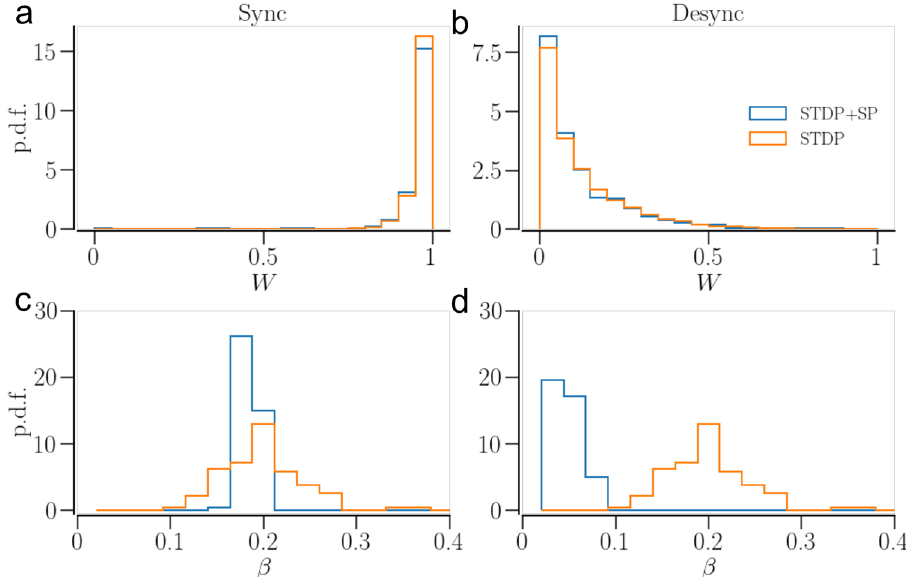
Figure 8. Statistics of synaptic weights and In-NDD for a network of identical oscillators in the asymptotic states belonging to the two plasticity schemes, STDP and STDP + SP. ( a ) and ( b ) show the synaptic weight distributions in a synchronized and a desynchronized state, respectively. ( c ) and ( d ) show the distributions of In-NDD in a synchronized and a desynchronized state, respectively. Parameters are a = 0.3 and γ = 3 . Initial conditions for the synchronized sate are β( 0 ) = 0.2 and � W � ( 0 ) = 1 ; and for desynchronized state β( 0 ) = 0.2 and � W � ( 0 ) = 0.25